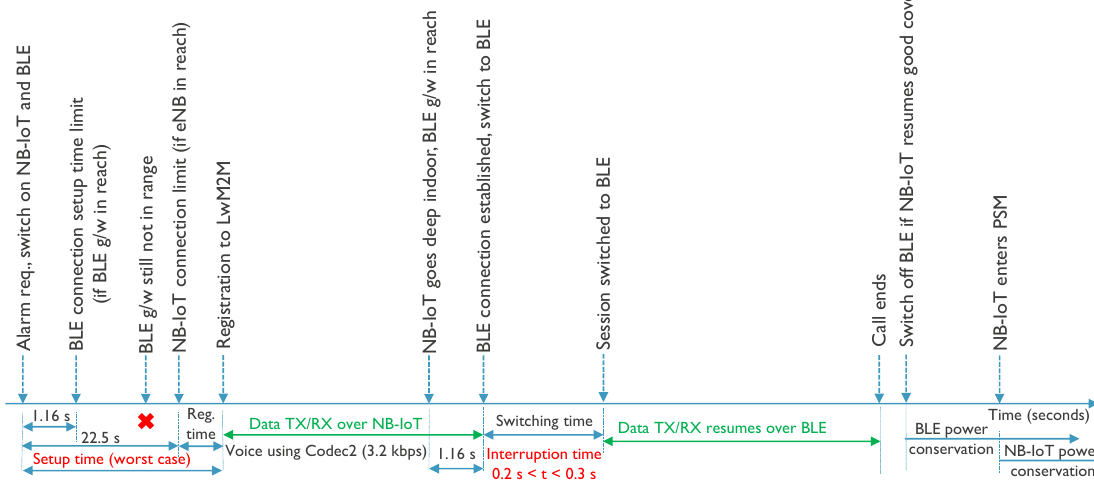
Figure 8. Active handover from NB-IoT to